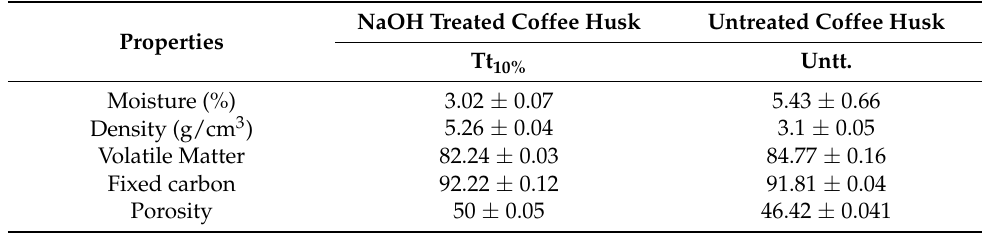
Table 1. Physical characteristics of coffee